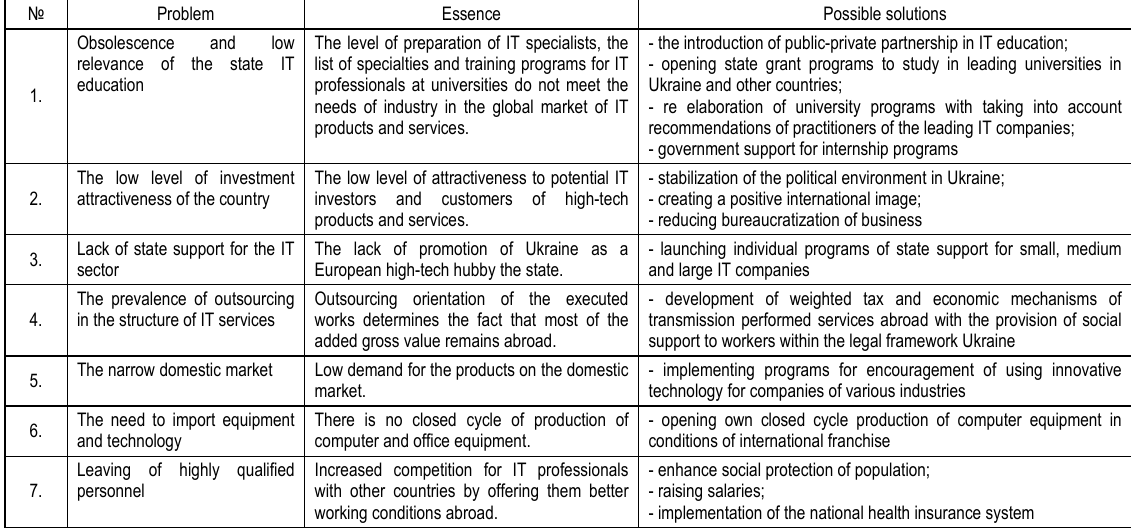
Table 2. System problems in the development of IT sector in Ukraine and and their possible